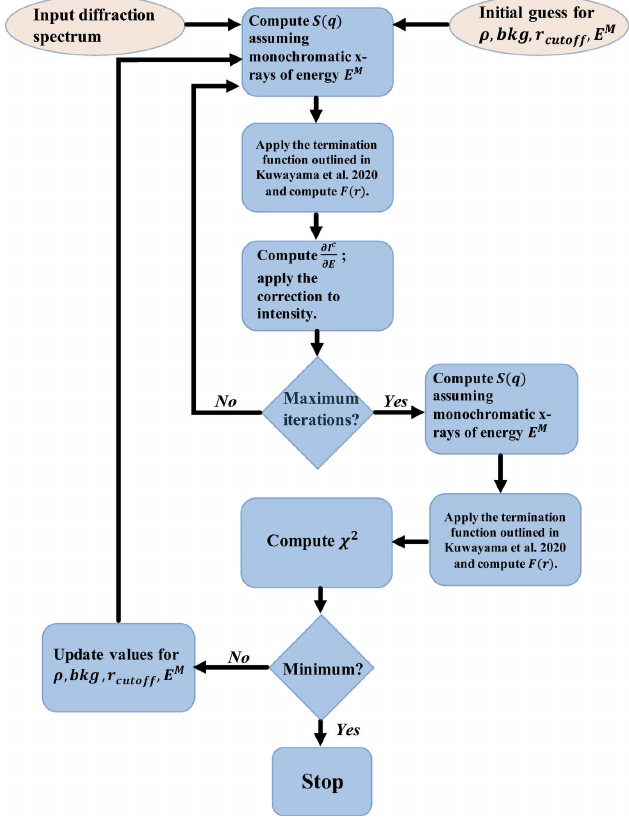
Figure 2 Density optimization algorithm. Symbols have been defined in the